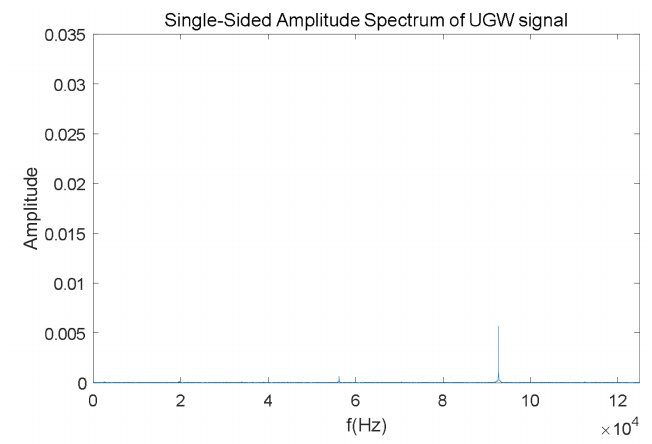
Figure 13. Frequency-domain representation for a train of UGW pulses S 2 in a broken track section, according to Figure 11.